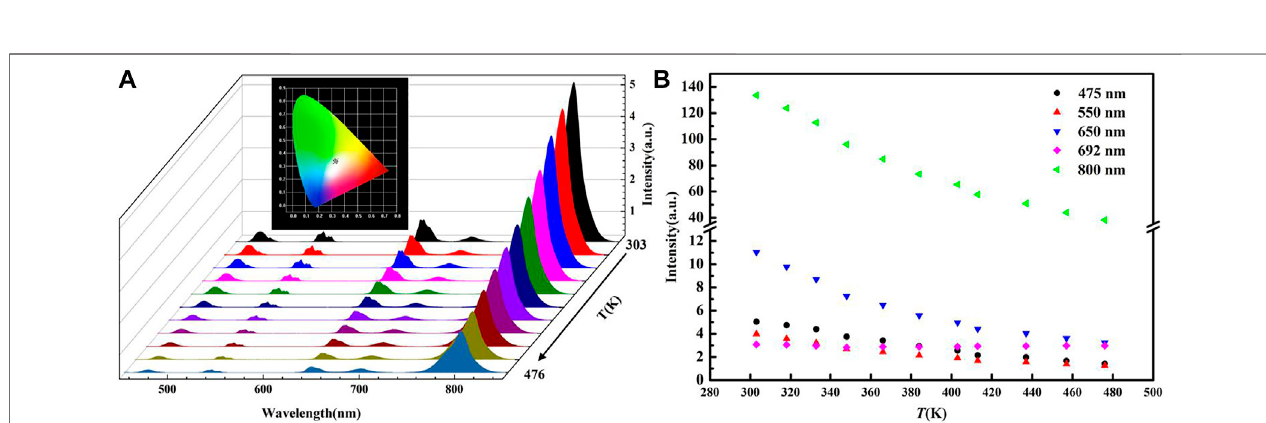
FIGURE 4 | Schematic energy levels, possible up-conversion processes, and energy transfer processes in Ho 3+ , Tm 3+ , and Yb 3+ -co-doped materials.